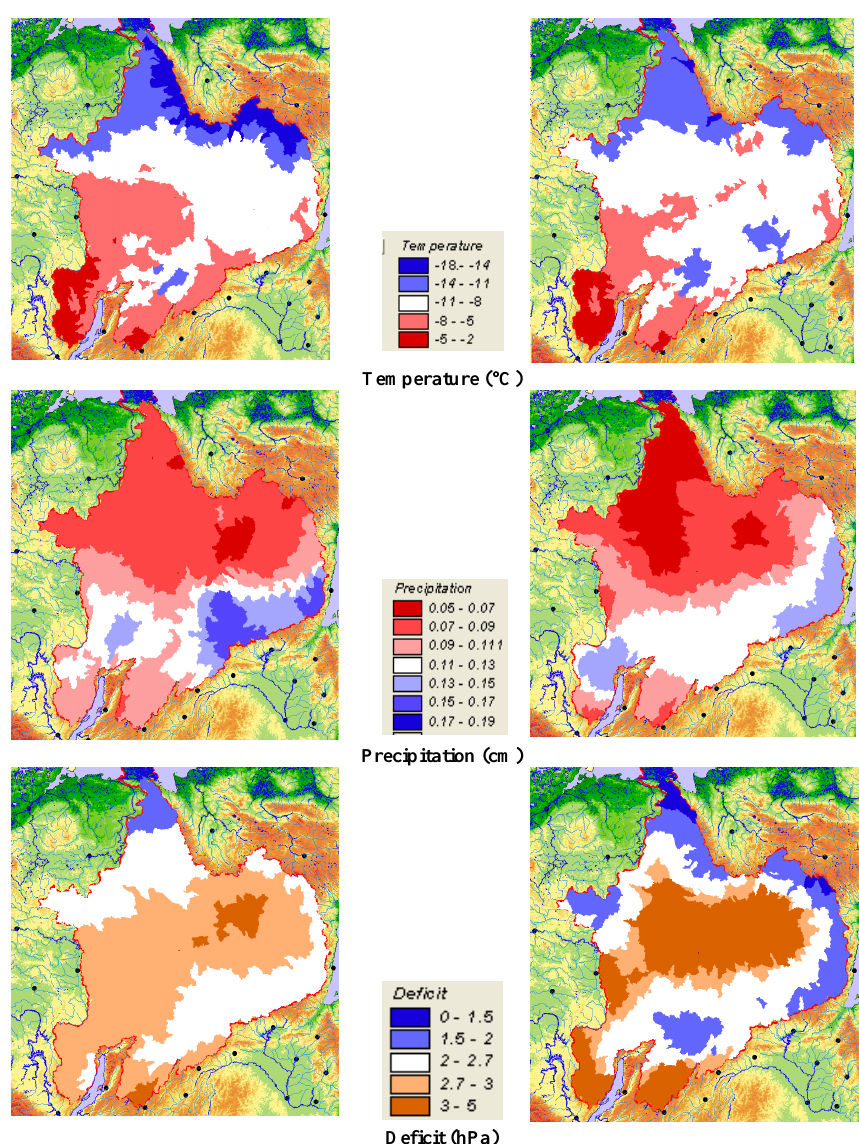
Figure 3. Observed (left panels) and the bias-corrected ECHAM5-simulated (right panels) patterns of mean annual values of air temperature ( ◦ C), precipitation (cm) and air humidity deficit (hPa) within the Lena River